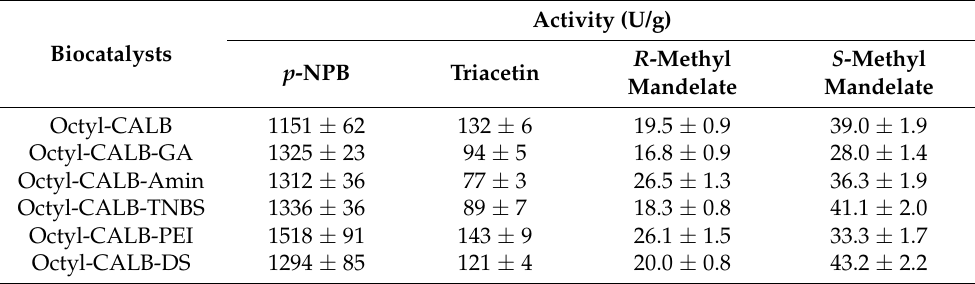
Table 5. Specific activity of different CALB biocatalysts with 1 mM p -NPB (pH 7 and 25 ◦ C), 50 mM triacetin (pH 7 and 25 ◦ C), and 50 mM R - or S -methyl mandelate (pH 7 and 25 ◦ C). Experiments were conducted as described in Methods.